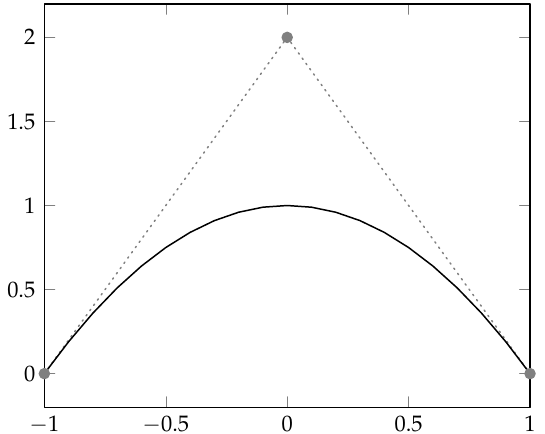
Figure 12. Parabolic arc considered for experiments in Section 5.3. Control points and polygon plotted in